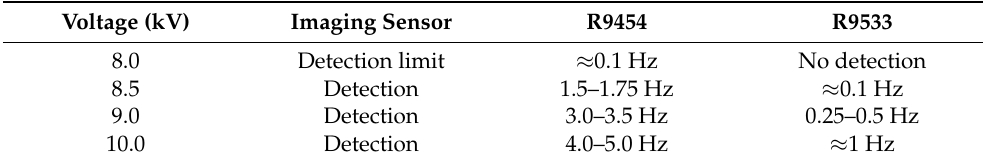
Table 3. Detection limit (CEV value) of the UVTRON sensors at a distance of 0.5 m from the discharge point.